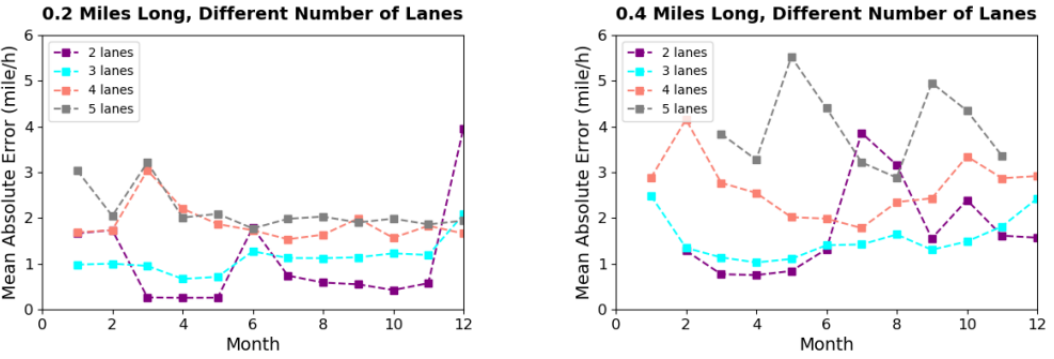
Figure 12. 0.2-mile series and 0.4-mile series.